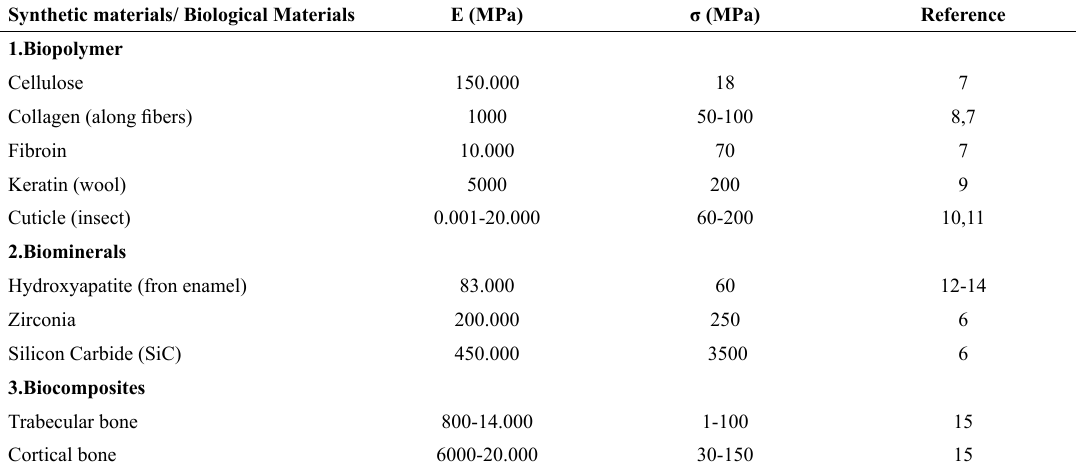
Table 1. Elastic modulus and tensile strength of biological and synthetic materials 15 . Synthetic materials/ Biological